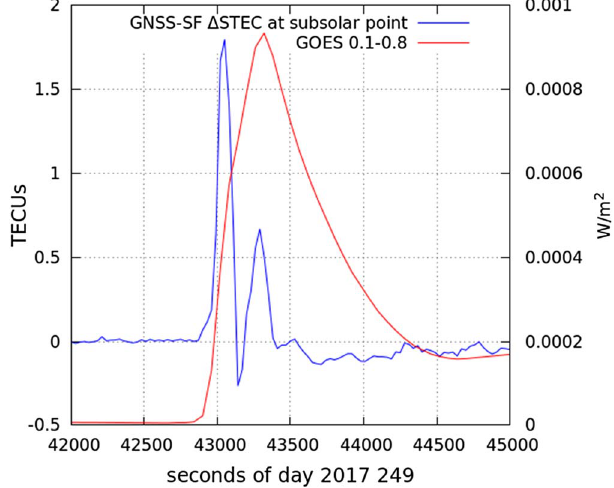
Fig. 3. D STEC values as a function of the cosine of the angular distance between the SSP and the IPP at two different epochs (43 050 s of the day in red, 42 900 s of the day in blue) for the day 249 (September 6) of 2017.